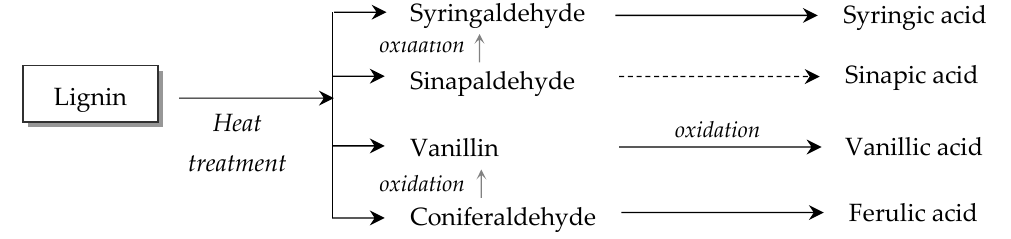
Figure 5. Mechanism of lignin’s decomposition and formation of derived compounds; proposed by [117].